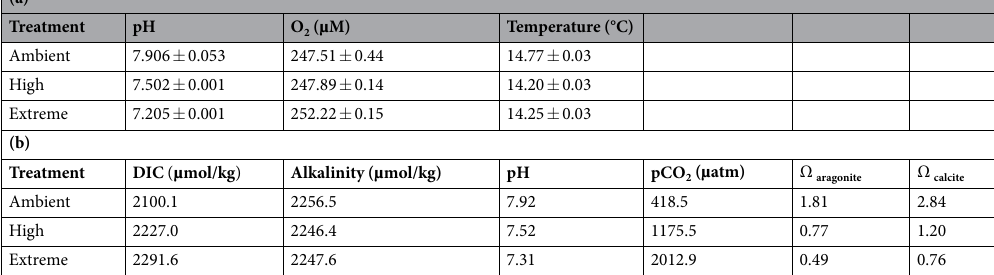
(Table 1a). The ambient treatment (418.5 µ atm pCO 2 ; pH 9.2; Ω arag 1.81) represented non-upwelling conditions in central California (pH 7.7–8.1) 35 . The high pCO 2 treatment (1,175.5 µ atm; pH 7.52; Ω aragonite 0.77) resembled the